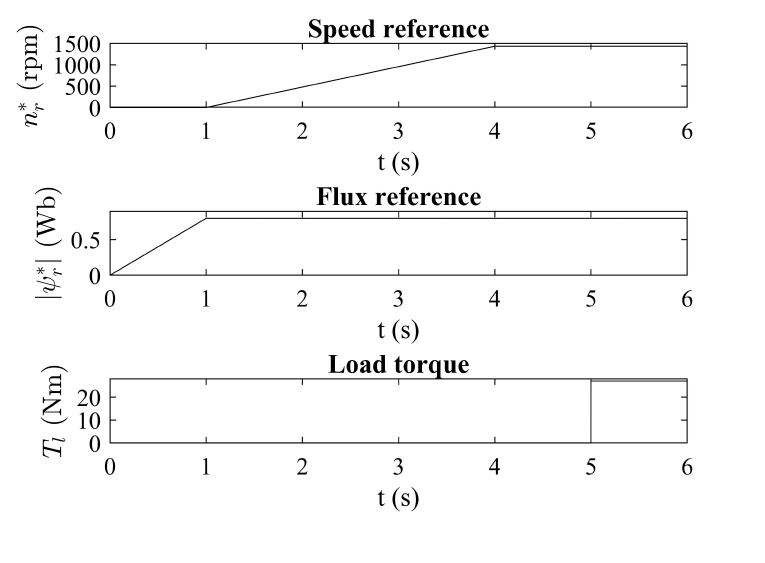
Figure 4. Reference and loading signals.